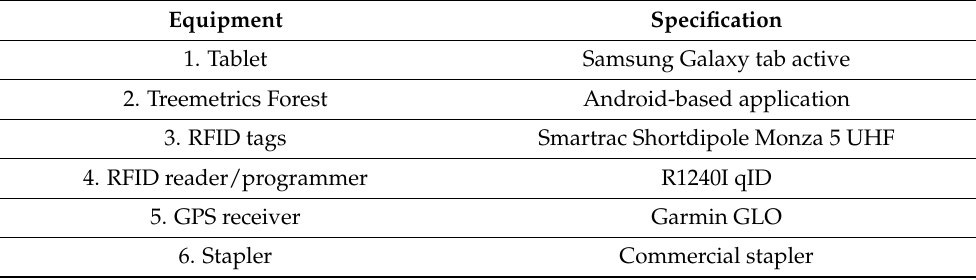
Table 4. RFID tree marking equipment.